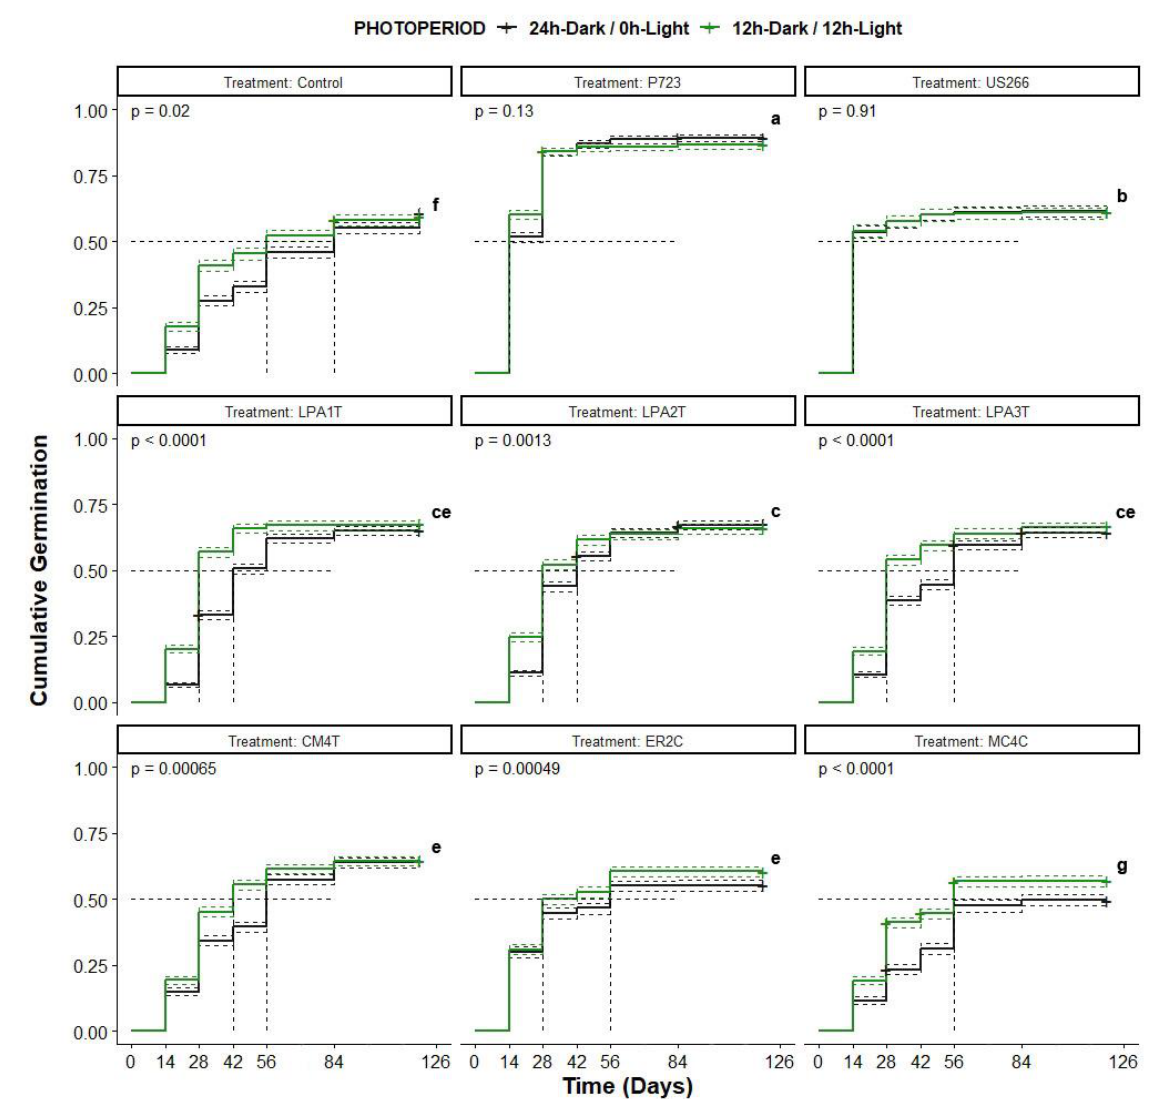
Figure 6. Cumulative proportion of germinated Epidendrum geminiflorum seeds co-cultured with different fungal strains under two photoperiods at 20 °C. Within each treatment, significant differences between photoperiods were not observed, with p -values greater than 0.05 according to a log-rank test at the α = 0.05 significant level. Curves with the same letters were not significantly different according to a multiple pair-wise comparison log-rank test of the treatment effect, with Bonferroni correction to adjust p -values to = 0.05 significance.